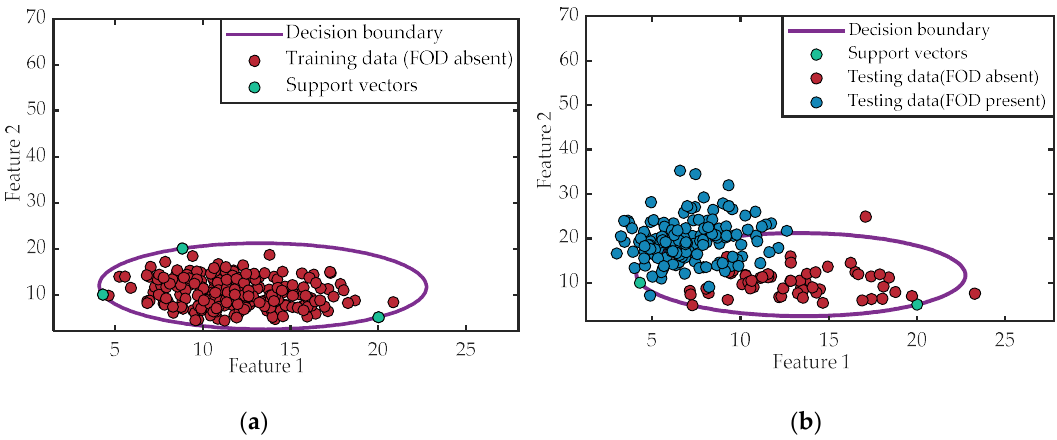
Figure 7. Detection results with the PSO support vector domain description (PSO-SVDD): ( a ) training procedure and ( b ) testing procedure.